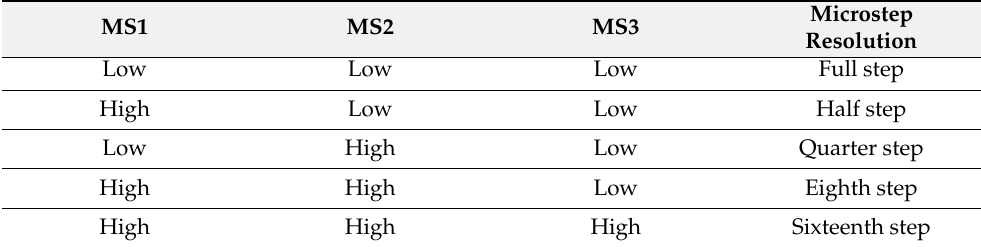
Figure 4. Stepper motor driver module. Table 1. Corresponding parameters of MS interface.